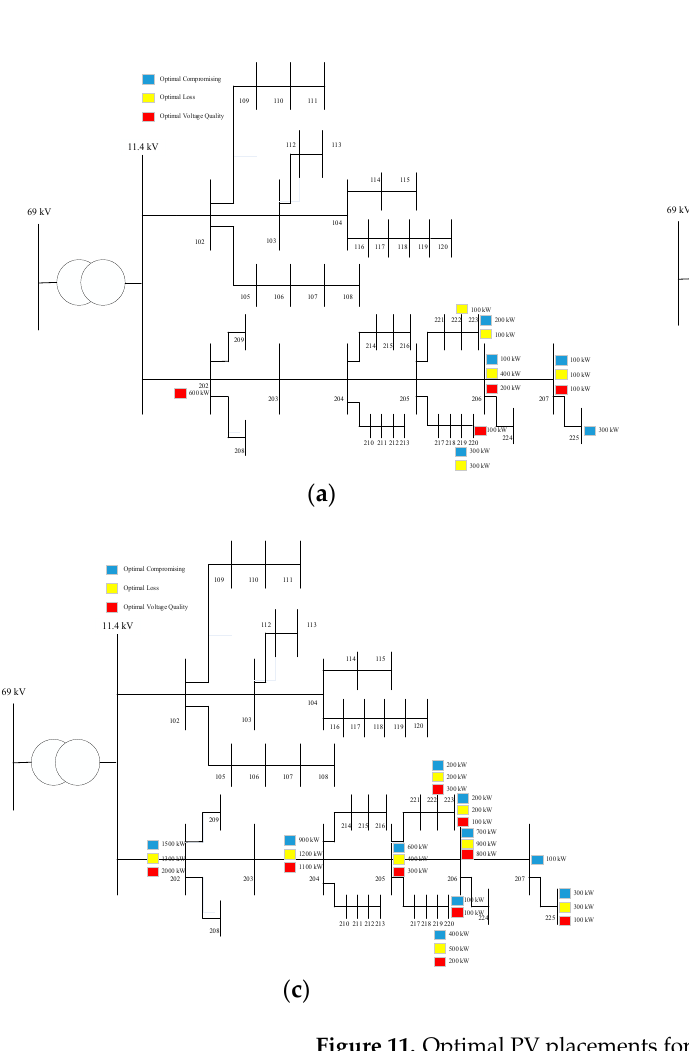
Figure 10. Optimal PV placements for Feeder1-Based simulation. ( a ) PV installed capacity 1000 kW; ( b ) PV installed capacity 3000 kW; ( c ) PV installed capacity 5000 kW.